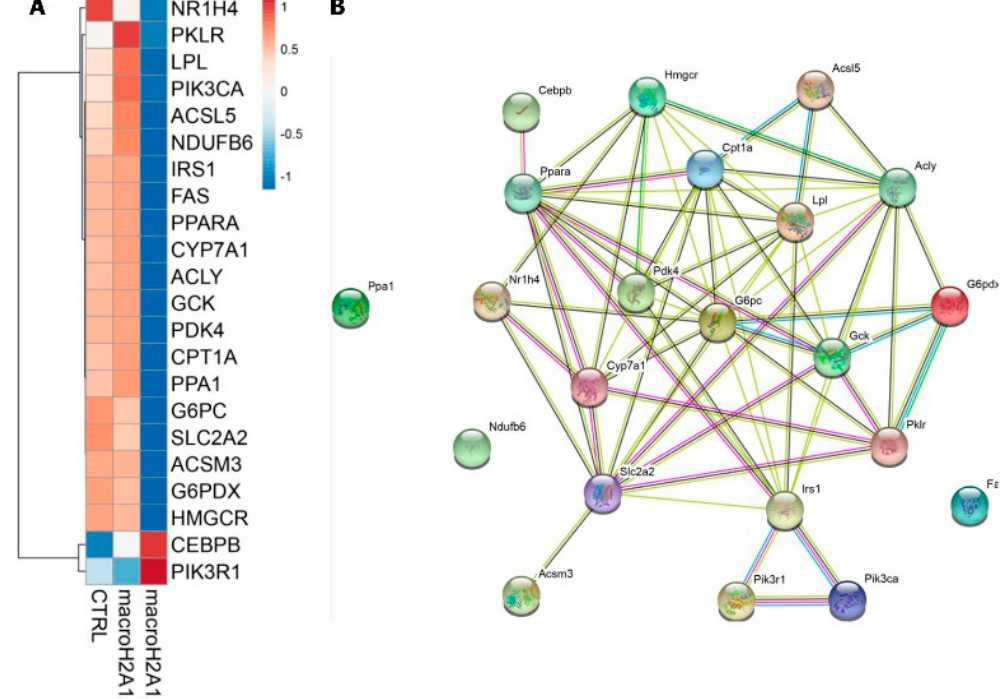
Figure 1. Isoform-specific impact of histone variant macroH2A1 on the expression level of circadian lipogenic genes involved in non-alcoholic fatty liver disease pathogenesis. ( A ) Heat-map rendering mRNA expression levels of 24-h oscillating genes upon free fatty acid challenge in Hepa 1-6 cells stably over-expressing histone variant macroH2A1.1 and macroH2A1.2 isoforms; ( B ) STRING interaction network wiring the 24-h oscillating genes rendered in the heat-map. Edges are colored according to the nature of the interactions between genes. Cyan and magenta links correspond to known interactions from curated databases and experimentally determined findings; green, red, and blue links correspond to predicted interactions by gene neighborhood, gene fusion, and gene co-occurrence, respectively; light green, black, and light blue links represent text mining, co-expression, and protein homology evidence of interaction, respectively. Original data from [22,75].